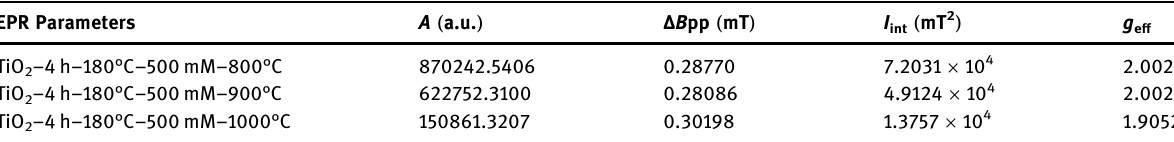
Table 2: EPR parameters for measurements at RT for studied samples